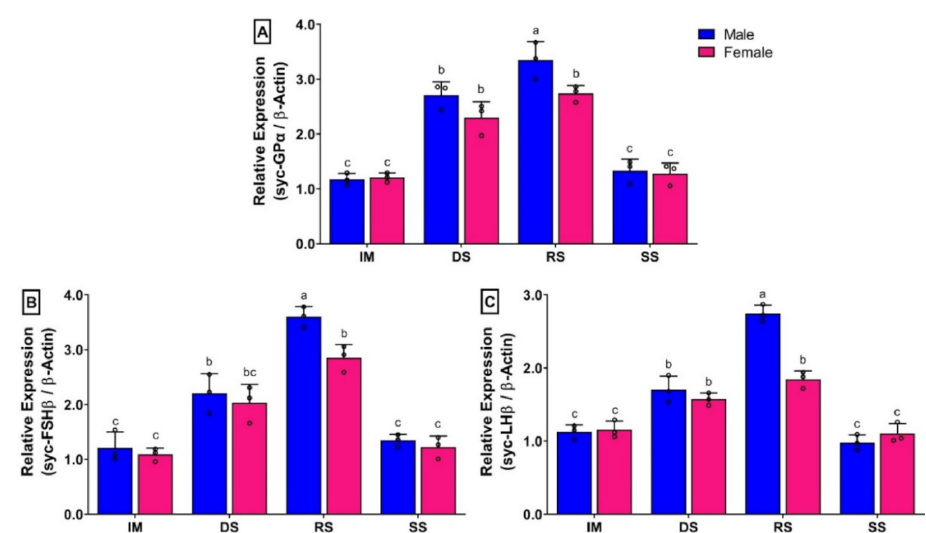
Figure 8. Relative mRNA expression levels (2 − ∆∆ CT ) of three GtH subunits in the pituitary during gonadal development stages in captive reared male and female small yellow croaker: ( A ) GP α , ( B ) FSH β , and ( C ) LH β . For all bar graphs, raw data points (black circle) represent biological replicates, error bars represent standard deviation, and different letters above the bars indicate significant differences ( p < 0.05) among developmental stages. IM, immature; DS, developing stage; RS, ripen stage; SS, spent stage.